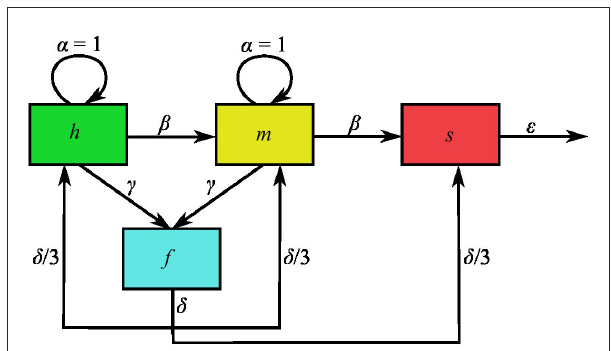
FIGURE1 Schematic representation of the mathematical model variables and interactions. Variables h , m , s , and f denote the volume density of healthy, moderately damaged, severely damaged and fused mitochondria, normalized to the carrying capacity, K . Moreover, the intrinsic-mitogenesis, damaging, fusion, fission, and mitophagy rate are respectively represented by parameters α , β , γ , δ , and ǫ . These parameters are normalized to the intrinsic mitogenesis rate, which is why α 1. =